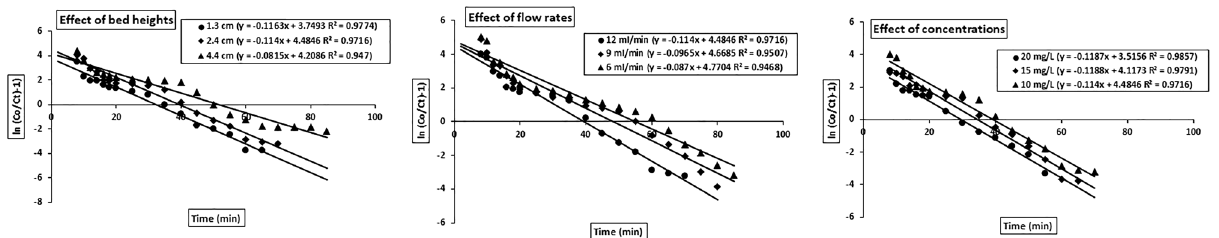
Figure 10. Thomas model linear fitting curve for bed height, flow rates and concentrations. The dots indicate experimental results while the lines show model